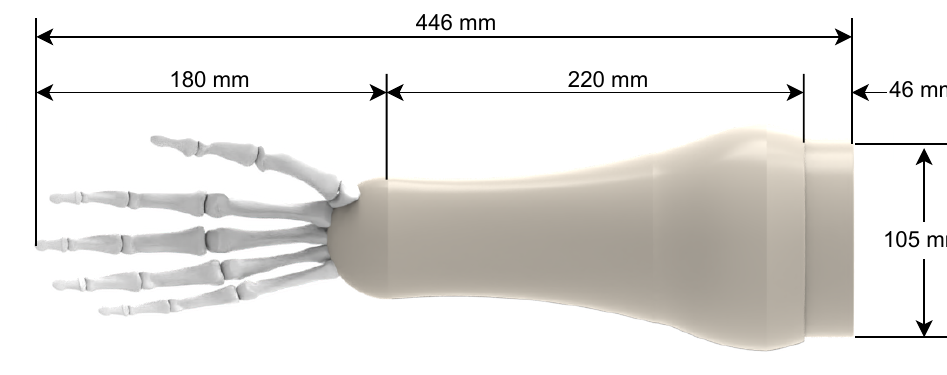
Figure 4. Socket dimensions.